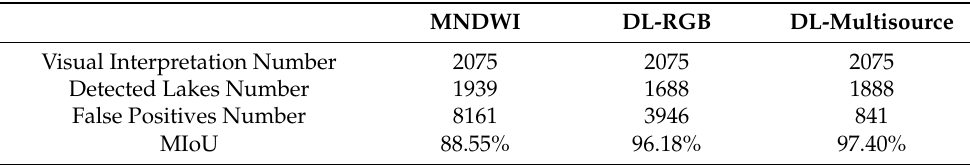
Table 7. Comparison of three methods for identifying alpine lakes.